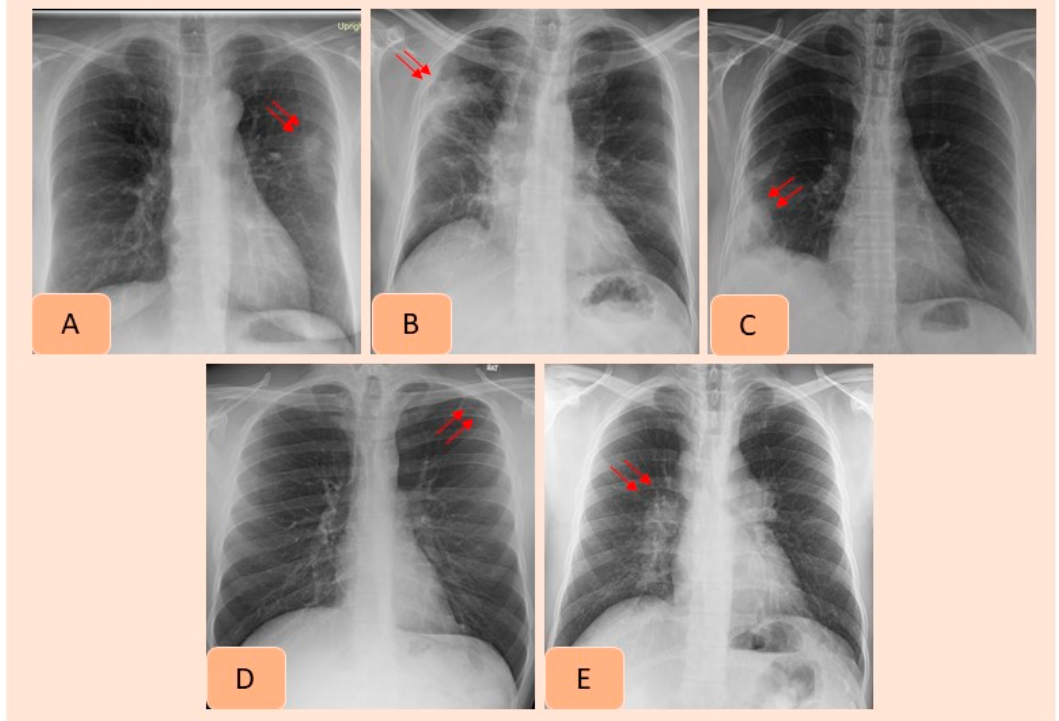
Figure 2. AI-detected CXR findings that were not documented in the radiology reports included pulmonary nodule ( A ), consolidation ( B ), pleural effusion ( C ), pneumothorax ( D ) and hilar prominence ( E ).